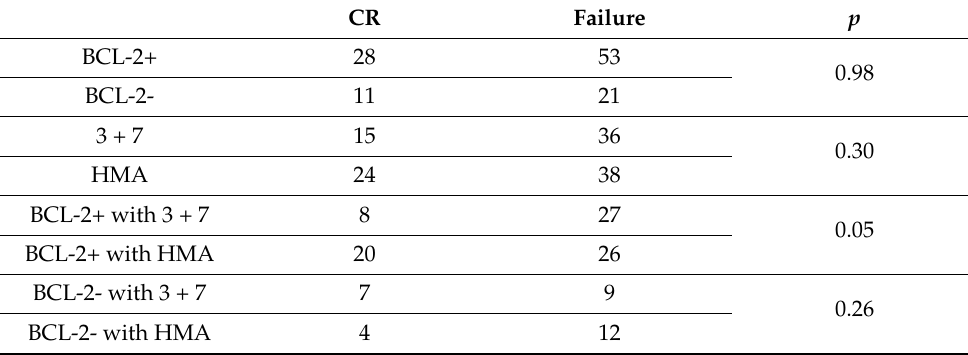
Table 2. CR rates according to BCL-2 expression and induction